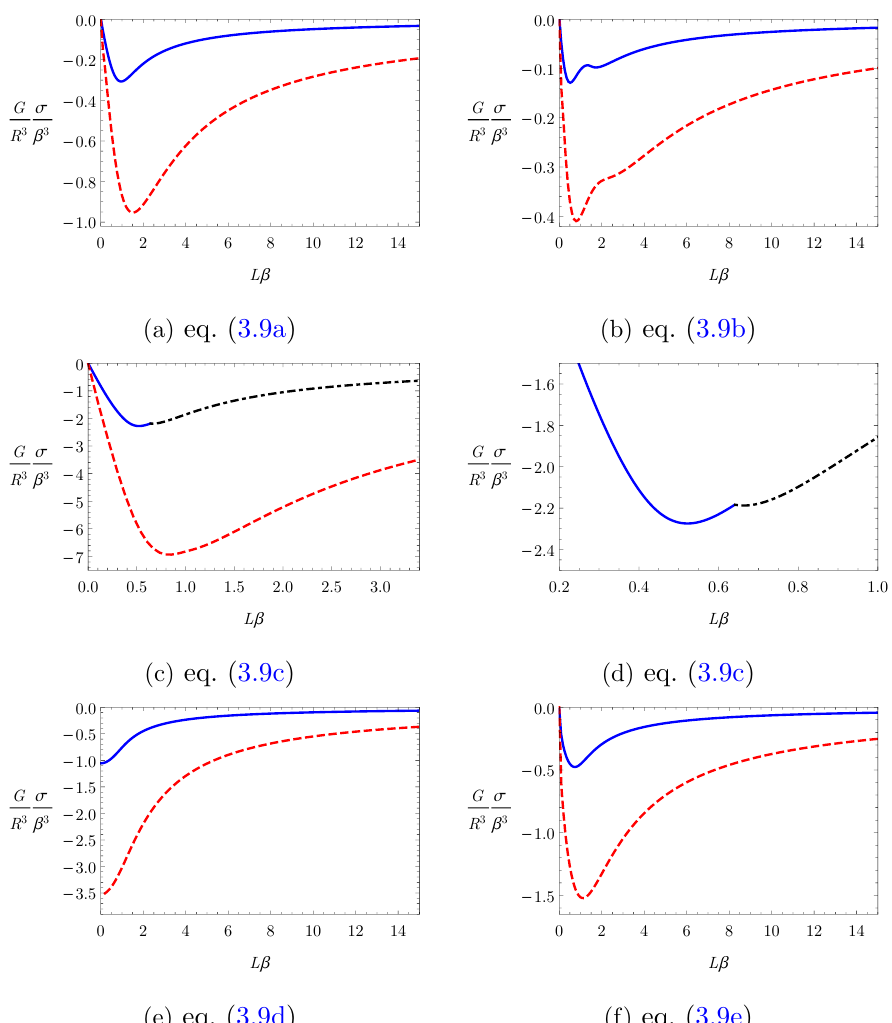
Figure 3. The ED, (cid:27) , in units of (cid:12) 3 R 3 =G , versus L(cid:12) for RG (cid:13)ows between holographic CFTs in d = 4. In each plot, the blue solid line is for the strip and the red dashed line is for the sphere. The label below each plot indicates the g ( z ) we chose from eq. (3.9). For the g ( z ) in eq. (3.9c), and for the strip only, a \(cid:12)rst-order phase transition" occurs between di(cid:11)erent extremal surfaces in the bulk when L(cid:12) (cid:25) 0 : 65, leading to the kink in (cid:27) shown in (c), and in close-up in (d), where the blue solid and black dot-dashed curves